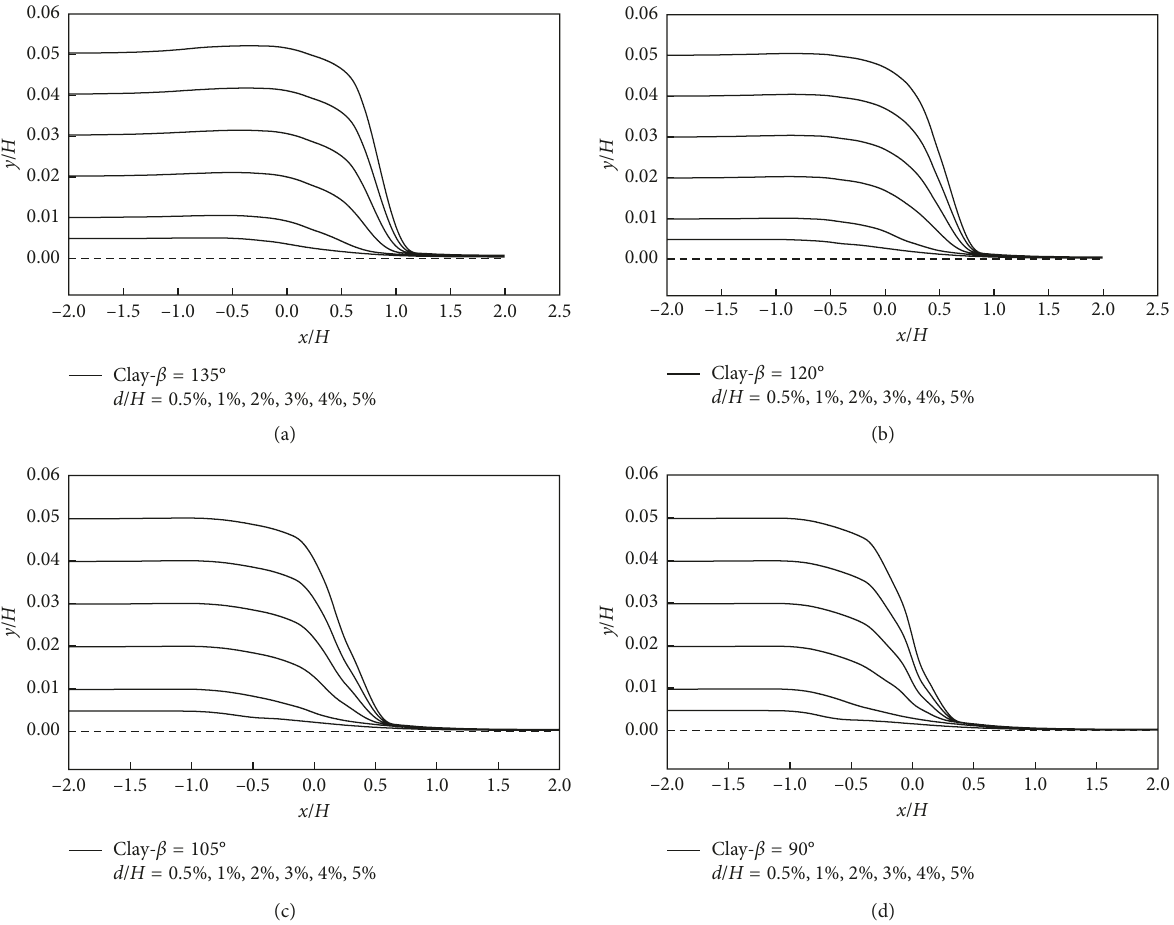
Figure 10: The ground displacement curves with different dip angles for the reverse fault in clay: (a) 45 ° , (b) 60 ° , (c) 75 ° , and (d) 90 °